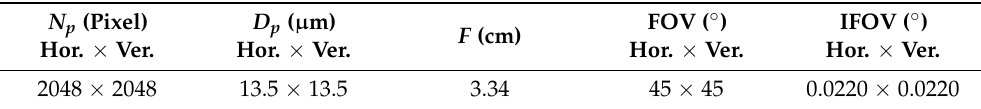
Table 3. Technical specifications of the eye-in-hand camera and its optics, assuming CCD42-40 is used as detector.